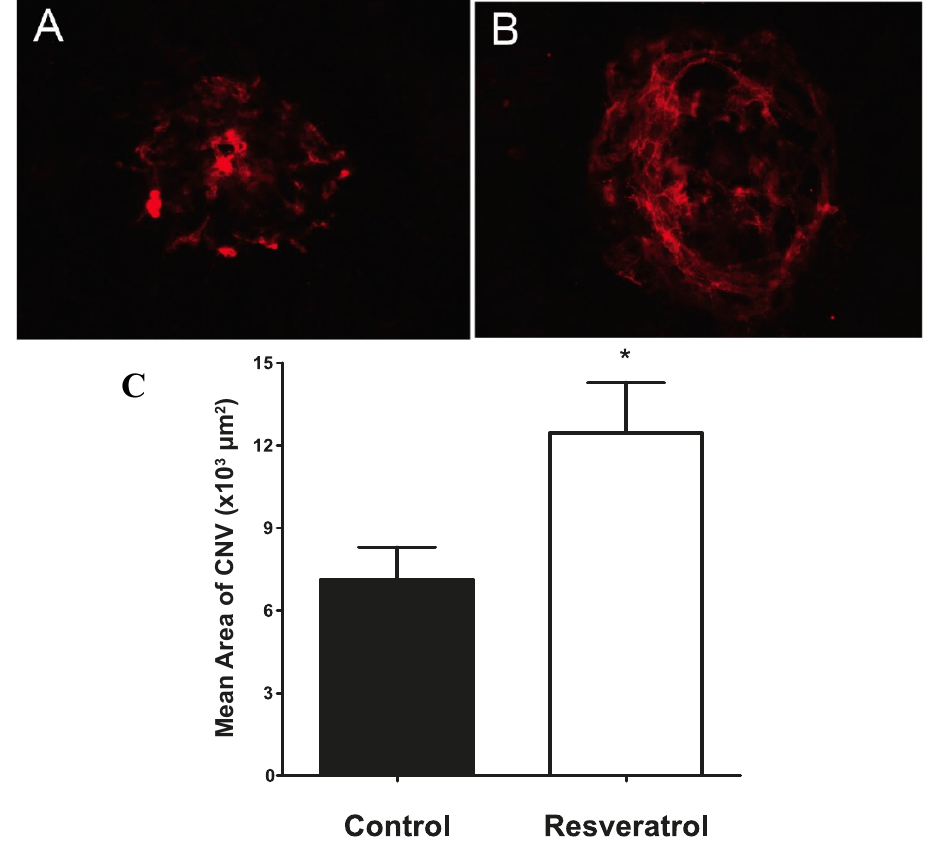
Figure 3. Single daily delivery of resveratrol enhances blood vessel formation in a mouse model of CNV. Representative sclerochoroidal flat mounts from mice receiving vehicle ( A ) or resveratrol ( B ) once daily by oral gavage. Treatment began five days prior to the induction of CNV and continued for a total of 16 days. ( C ) Quantification of the data ( * p value = 0.023; n = 18